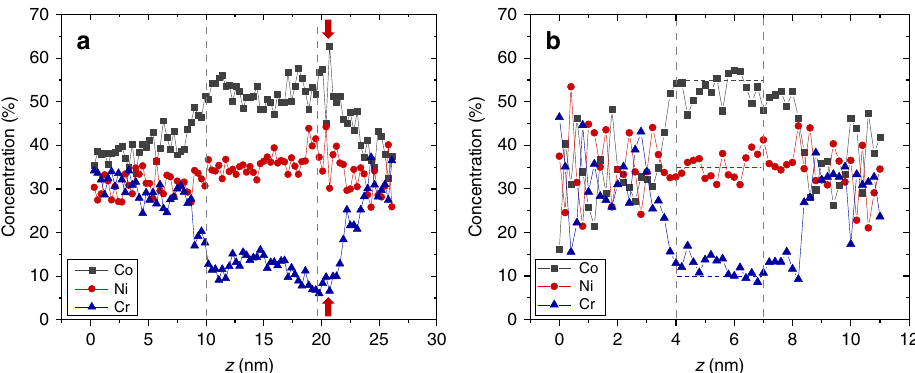
Fig. 7 1D concentration pro fi les across voids in NiCoCr. a is based on the experimental APT reconstruction and b is based on the simulated APT reconstruction. Horizontal dashed lines in b indicate the ground truth elemental concentrations in the simulation. Pro fi les were obtained by calculating element concentrations in 0.3 nm-wide bins from cylindrical ROIs passing through the void. As the simulated APT tip size is smaller than the experimental APT tip size, the x axis of experimental and simulated pro fi les cannot be compared directly. More details related to dimension of the simulated APT tip is provided in Methods section. (Fig. 6h) due to the higher evaporation fi eld of the shell and Table 1 Chemical composition in Co, Ni, and Cr (at.%) of the results in a decrease in local atomic density. This density variation simulated matrix and